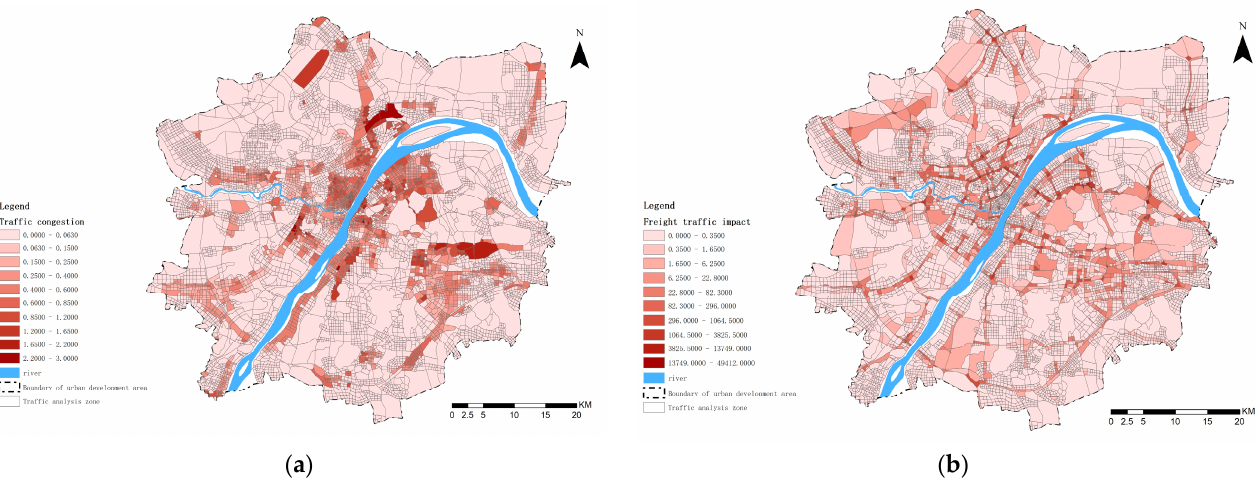
Figure 13. Road and traffic: ( a ) Traffic congestion; ( b ) Freight traffic impact.